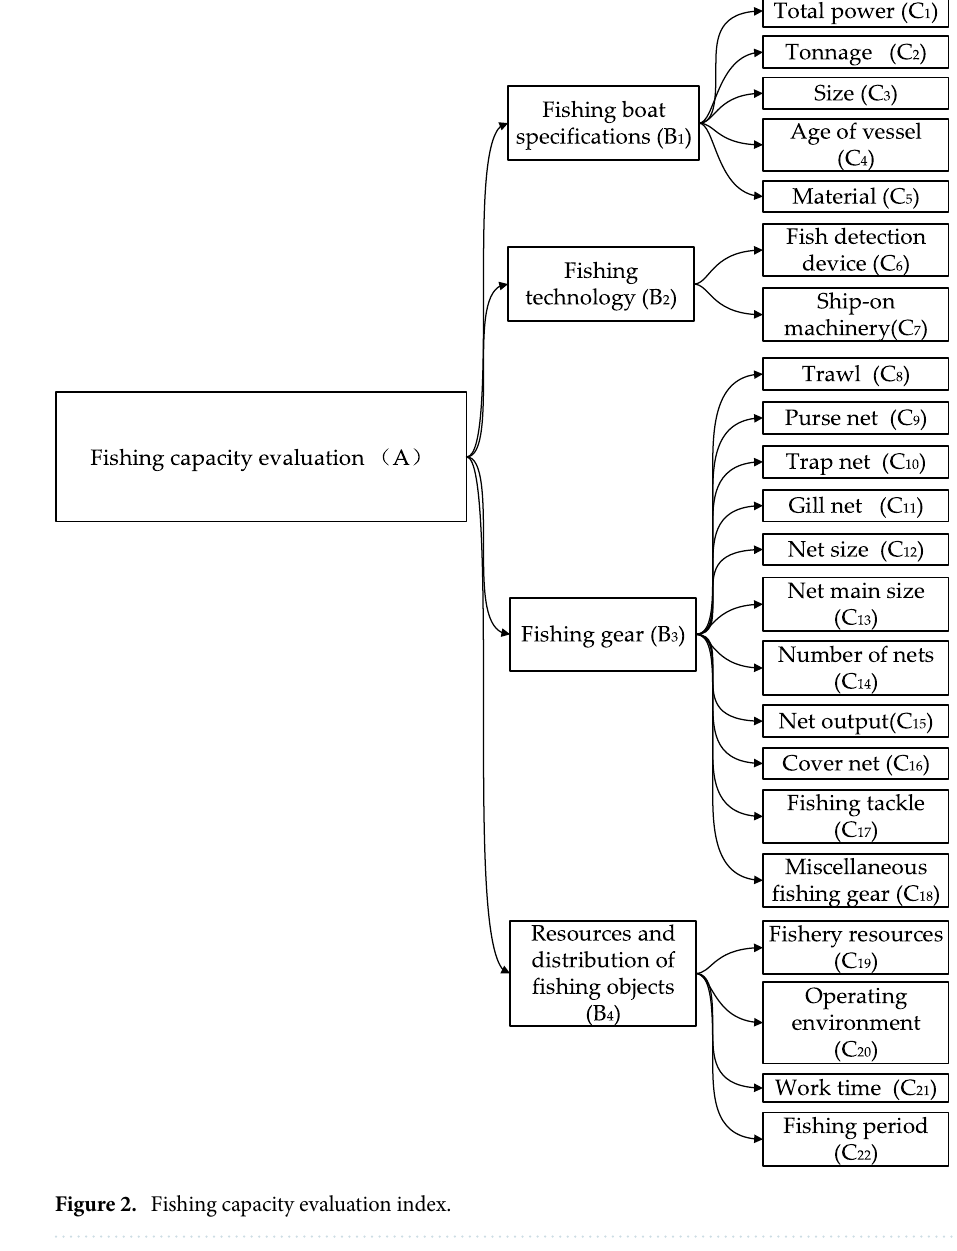
Figure 2. Fishing capacity evaluation